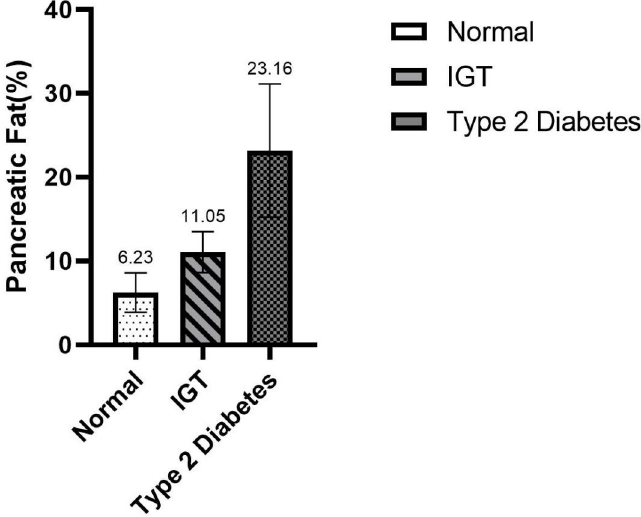
Fig 6. The fat content of pancreas in IGT group and diabetic group was higher than that in normal group, however, there was no significant characteristic difference on MR mDixon images of the pancreas, the difference in fat content can only be confirmed by